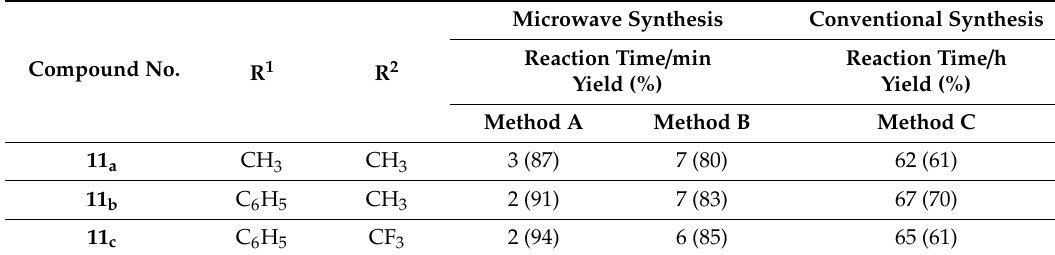
Compound No. R 1 R 2 Compound